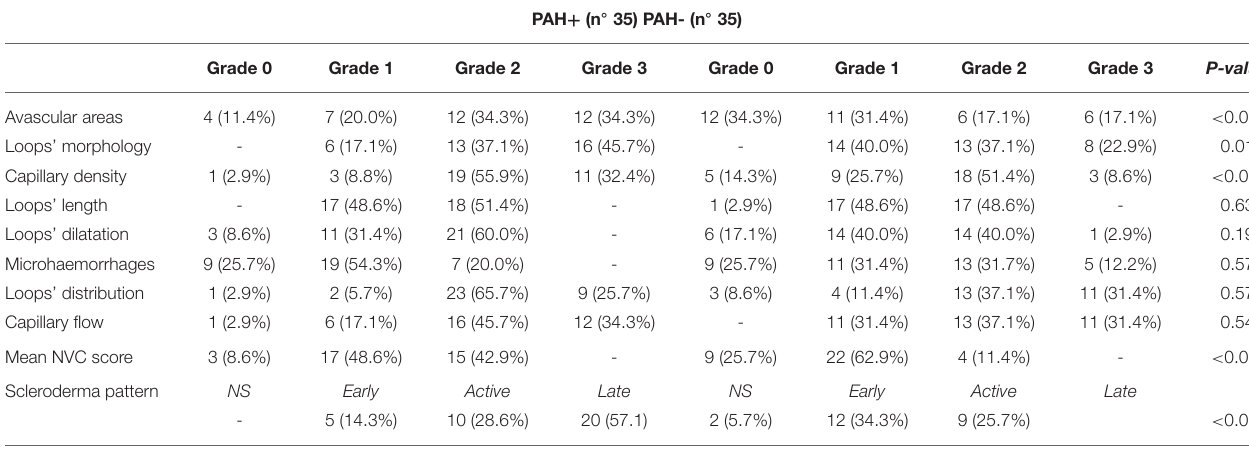
TABLE 2 | Capillaroscopic findings in patients with or without pulmonary hypertension (PAH).